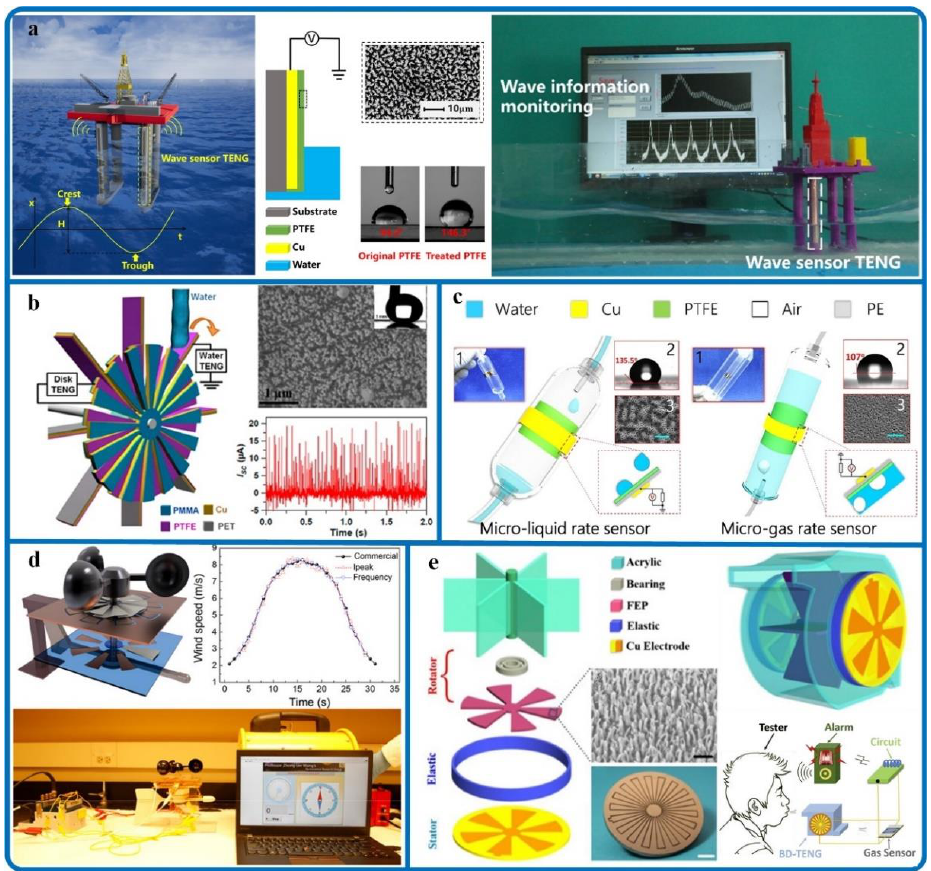
Figure 8. Different forms of fluid sensors based on TENG. ( a ) Schematic of using a water TENG device for self-powered wave sensing based on wave energy. Reproduced with permission [93].